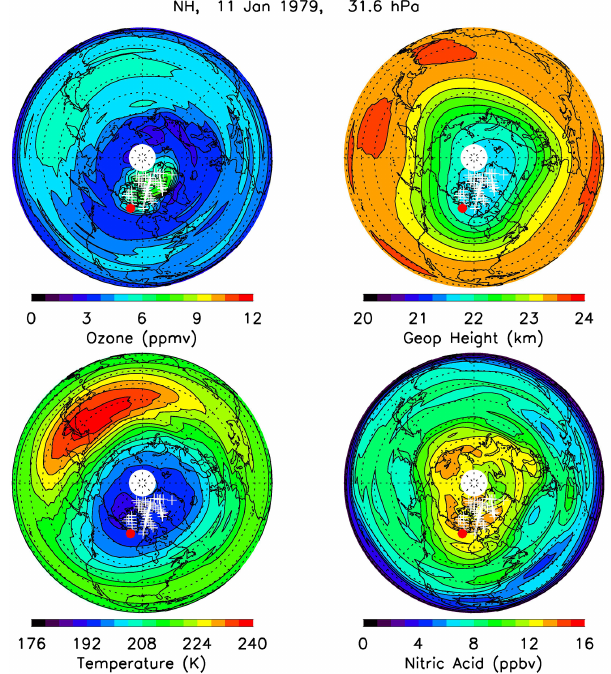
Figure 2. Polar orthographic projections of Northern Hemisphere ozone (top left), geopotential height (gph, top right), temperature (bottom left), and nitric acid vapor (bottom right) for 11 Jan- uary 1979 at 31.6hPa; successive latitude circles are at every 10 ◦ . The Greenwich meridian extends horizontally to the right. Contour intervals are every 0.75ppmv for ozone, 0.25km for gph, 4K for temperature, and 1ppbv for nitric acid vapor. White plus signs de- note orbital profile segments that were screened out; red dot denotes location of SAM II PSC observation.